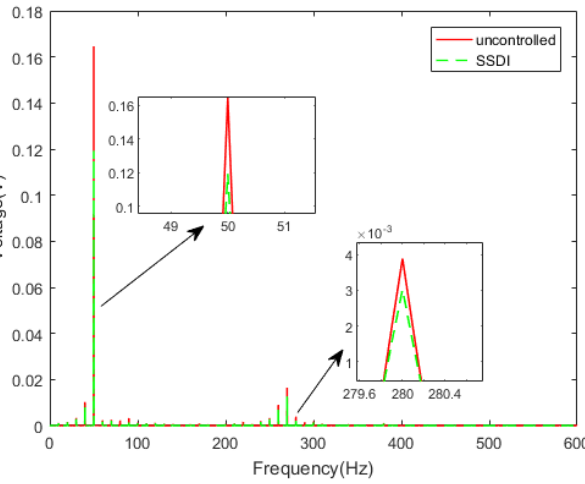
Figure 24. Displacement response curves in the time domain with and without the SSDI (white noise).